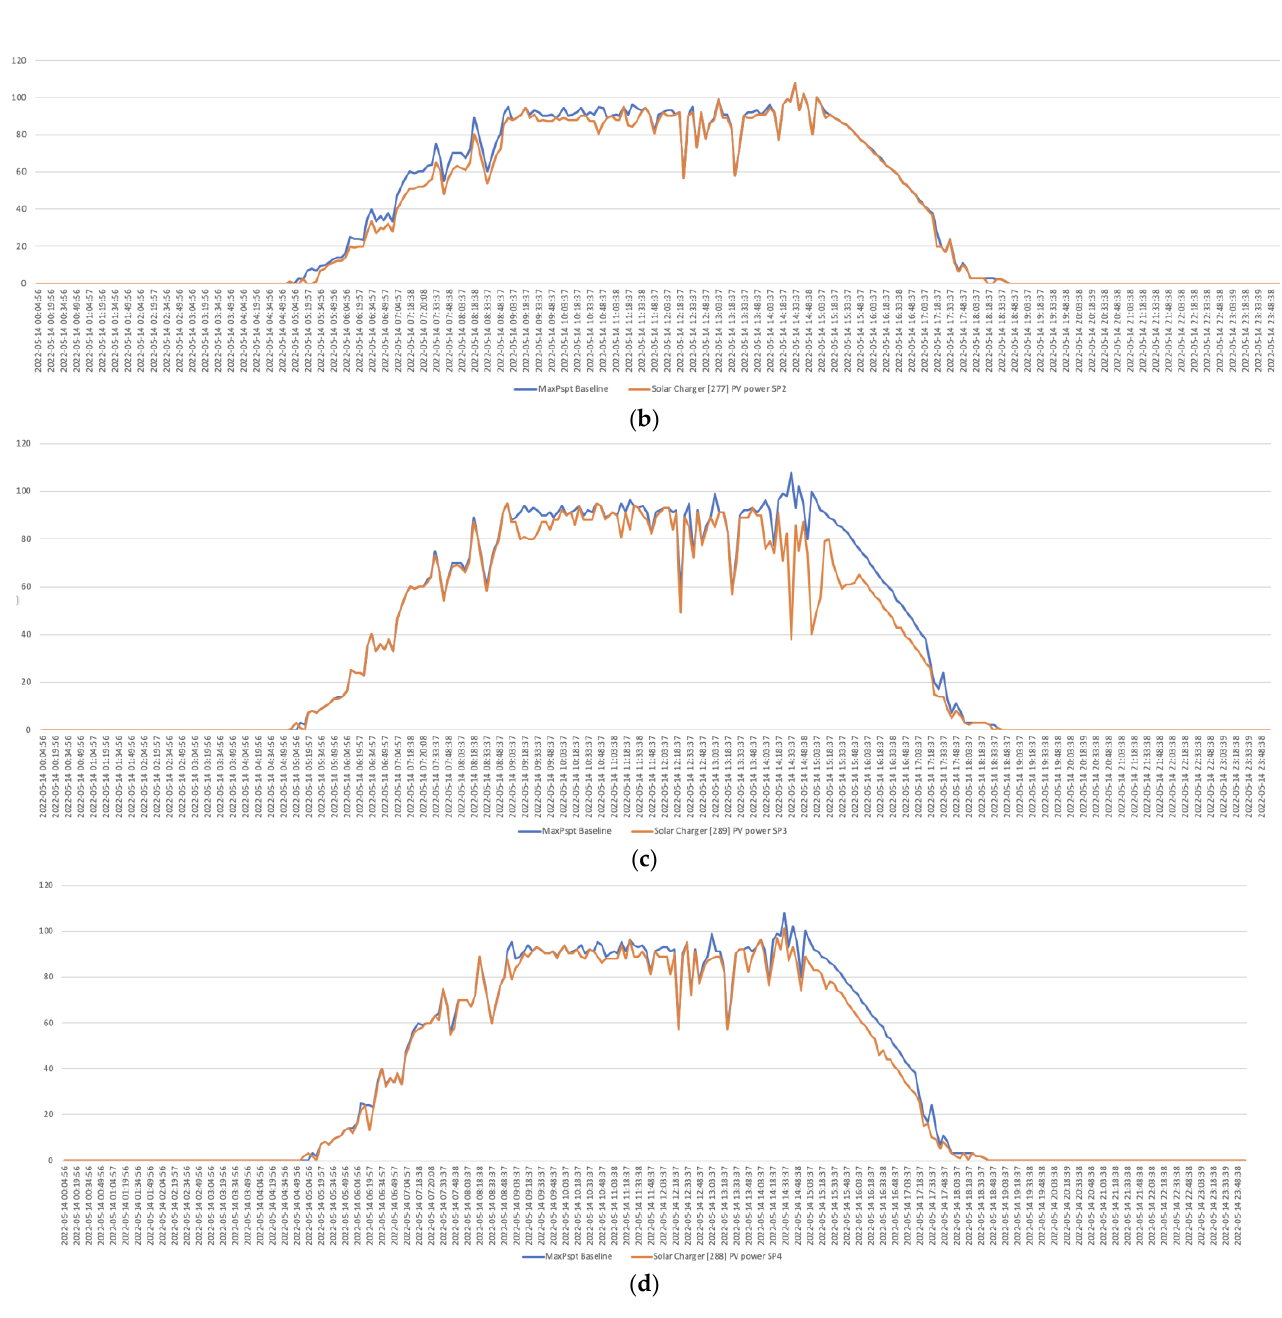
Figure 26. Comparative analysis of the baseline obtained from each of the MaxPspit values and the specific values of the power generated in each solar panel: ( a ) SP1; ( b ) SP2; ( c ) SP3; ( d ) SP4.